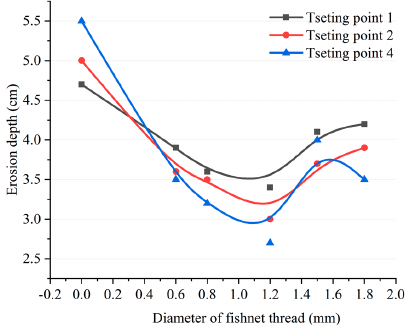
Figure 21. Erosion depth when fishnet thread had different diameters.